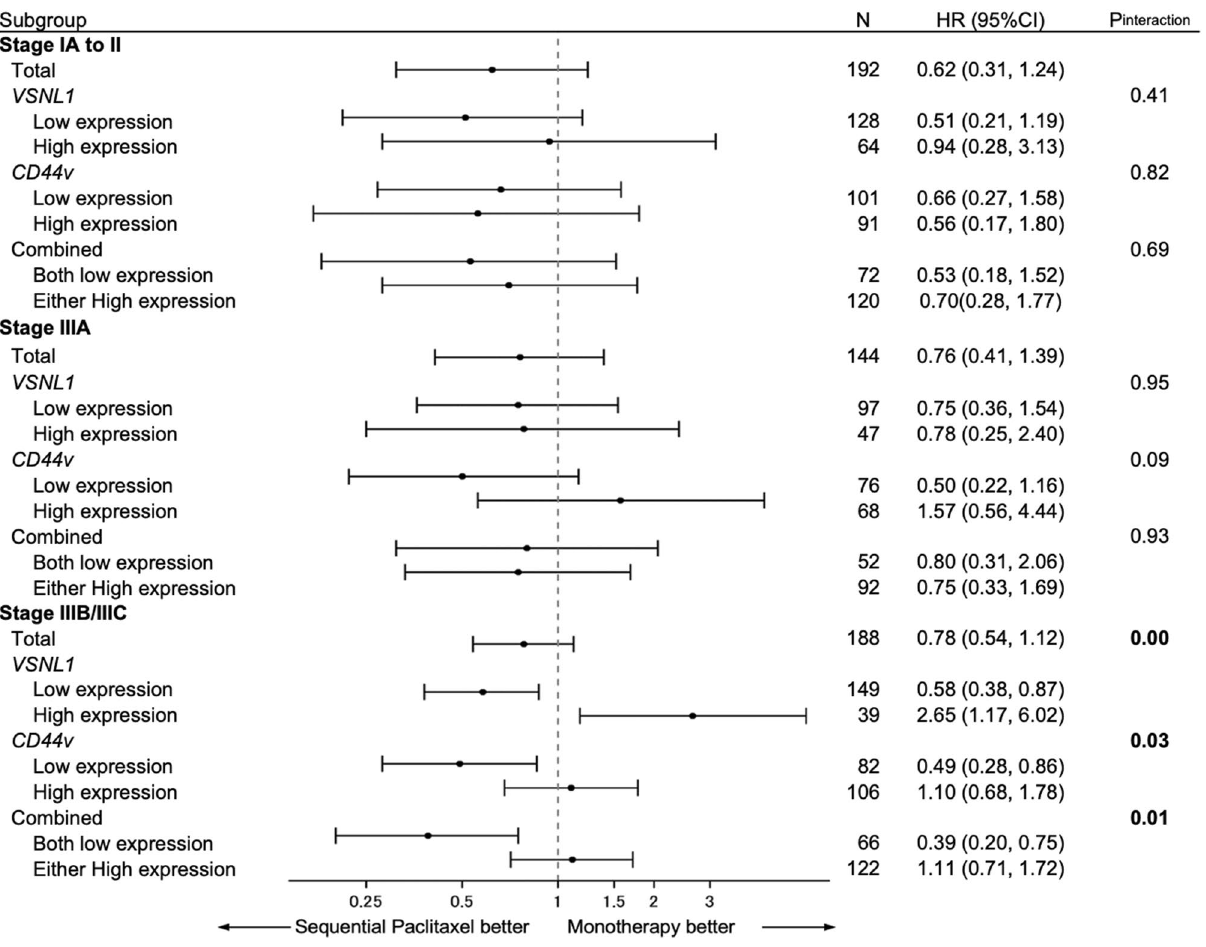
Figure 3. Forest plot of the study results. After patient stratification based on the pTNM stage, the survival benefit from sequential paclitaxel treatment was greater among patients with stage IIIB gastric cancer with a low expression of either gene or both. The association between the low expression levels of VSNL1 and CD44 and potential benefits from sequential paclitaxel treatment were significant for disease-free survival and cumulative incidence of relapse.